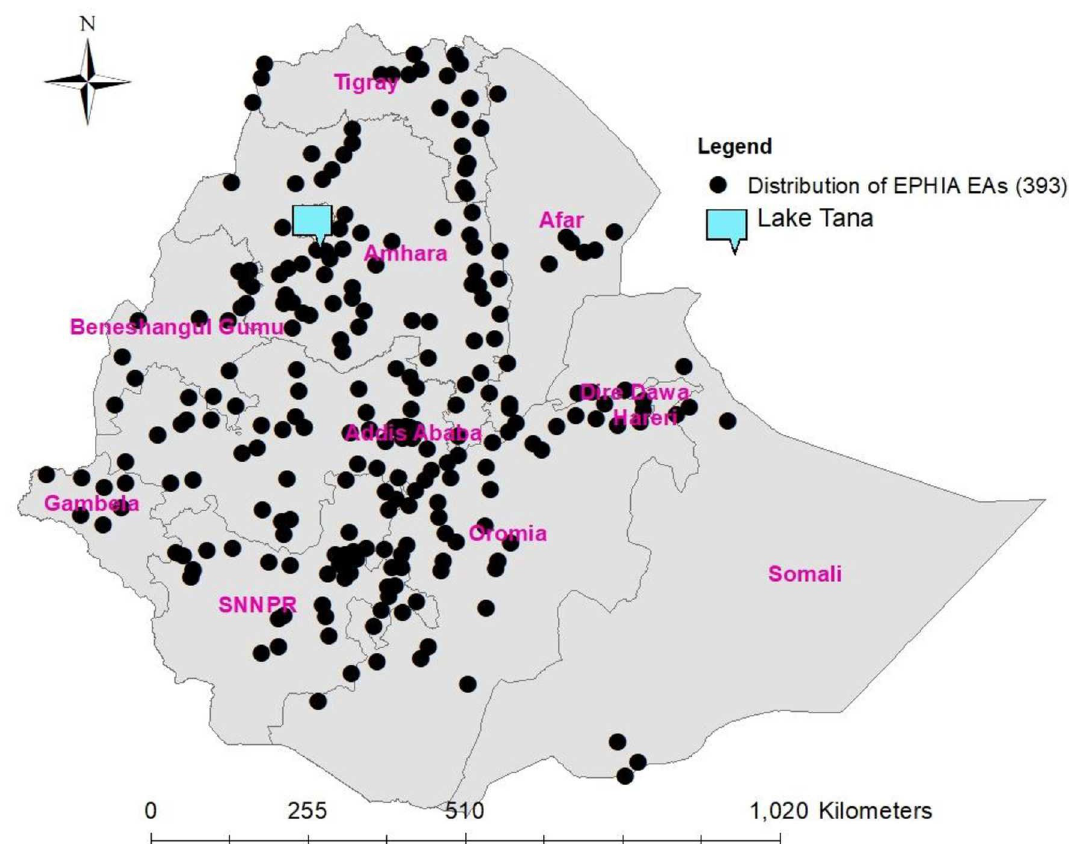
Fig 1. Distribution of enumeration areas (N = 393) selected for Ethiopia Population-based HIV Impact Assessment Survey (2017–2018).